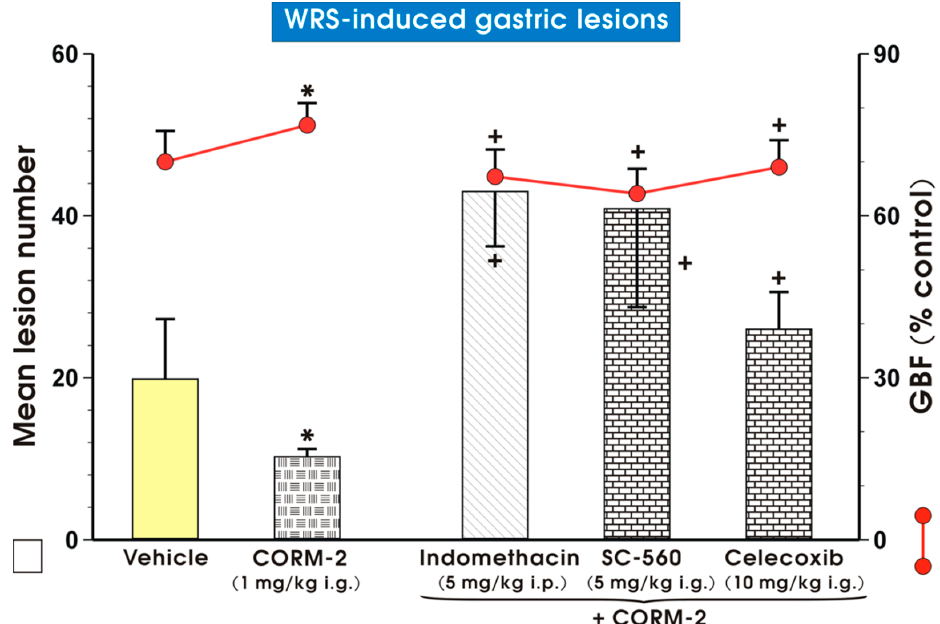
Figure 6. Mean lesion number and gastric blood flow (GBF) in gastric mucosa pretreated i.g. with vehicle (saline; yellow pattern), carbon monoxide releasing molecule 2 (CORM-2, 1 mg/kg i.g.) alone (mosaic pattern) or administered in combination with non-selective cyclooxygenase (COX) inhibitor, indomethacin (5 mg/kg i.p.; line pattern), selective COX-1 inhibitor, SC-560 (5 mg/kg i.g.; brick pattern) or selective COX-2 inhibitor, celecoxib (10 mg/kg i.g.; brick pattern) and 30 min later exposed to 3.5 h of water immersion and restraint stress (WRS). Results are mean ± S.D. of 6–8 animals for each experimental group. Asterisk indicates significant change ( p < 0.05) as compared with vehicle (saline) controls. Cross indicates significant change ( p < 0.05) as compared with the group treated with CORM-2 (1 mg/kg i.g.) alone.